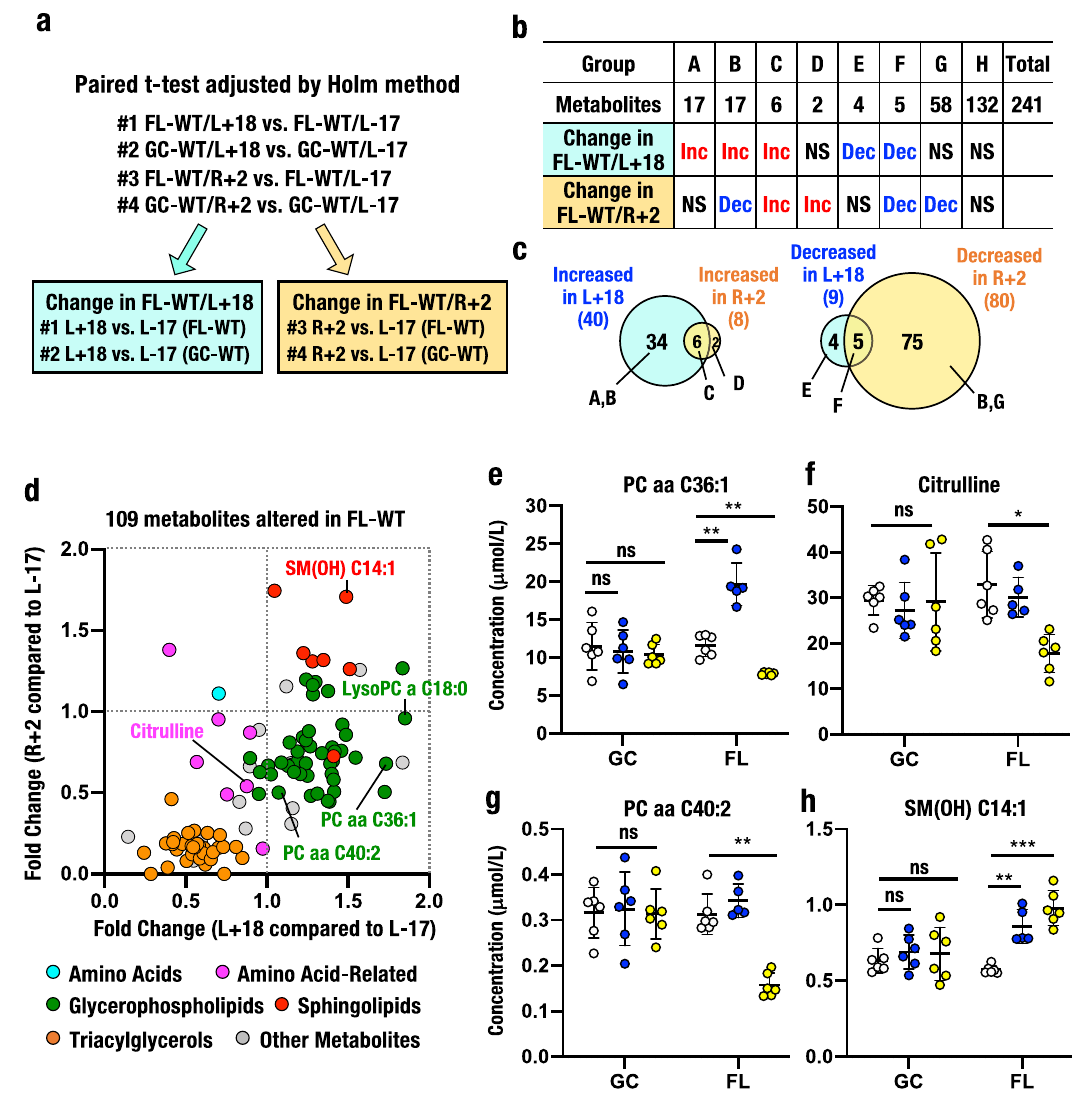
Fig. 3 Metabolic responses observed in WT mice during and after space fl ight. a Statistical analyses to identify altered metabolites in FL-WT mice. Paired t -tests were performed between time points (L + 18 vs . L-17, #1 for FL-WT and #2 for GC-WT; R + 2 vs . L-17, #3 for FL-WT and #4 for GC-WT), and P values were adjusted using the Holm method. Altered metabolites were determined based on an adjusted P < 0.05 and combinations of comparisons (#1 and #2 for L + 18, blue box; #3 and #4 for R + 2, yellow box). b Numbers of increased (Inc) or decreased (Dec) metabolites during (change in FL-WT/L + 18) and after (change in FL-WT/R + 2) space fl ight. c Venn diagram of increased (left) or decreased (right) metabolites selected through a combination of statistical analyses. d Relationship between fold changes (FC) observed at L + 18 compared to L-17 and R + 2 compared to L-17 in FL-WT mice. The plot shows 109 metabolites whose levels were altered in FL-WT mice at L + 18 (horizontal axis) and R + 2 (vertical axis). Note the marked clusters of changes in metabolites in this plot. e – h Representative metabolites whose levels were altered during and after space fl ight (FL) compared with GC. One signi fi cantly altered metabolite at FL L + 18 is PC aa C36:1 ( e ), two signi fi cantly altered metabolites at FL R + 2 are citrulline ( f ) and PC aa C40:2 ( g ), and one signi fi cantly altered metabolite at both FL L + 18 and R + 2 is SM(OH) C14:1 ( h ). The results are presented as the mean plasma concentrations ( μ mol/L) ± SD. *Adjusted P < 0.05, **adjusted P < 0.01 and ***adjusted P < 0.001. ns not signi fi